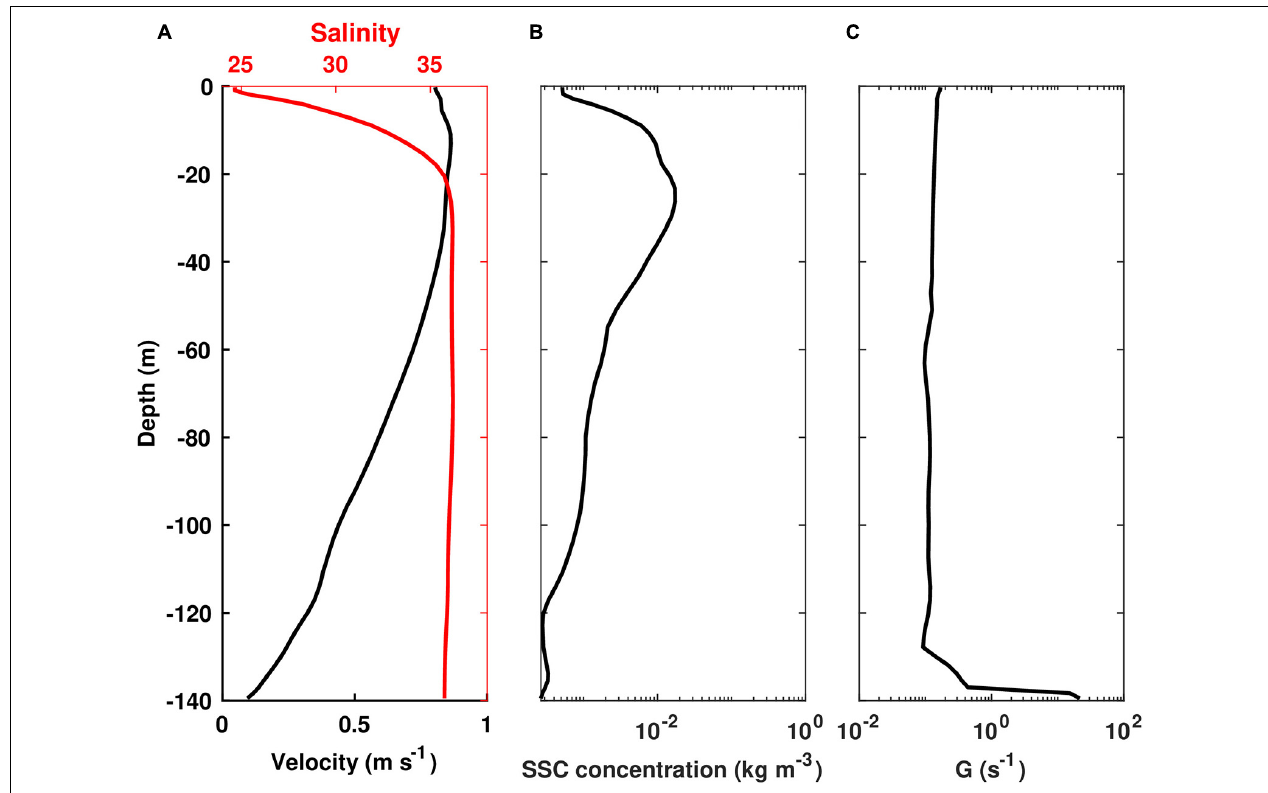
FIGURE 8 | Profiles of (A) velocity and salinity, (B) initial suspended sediment mass concentration, and (C) shear rate for the river plume scenario ( A,B are based on model output from Harris et al., 2020. C is from 1D model output).